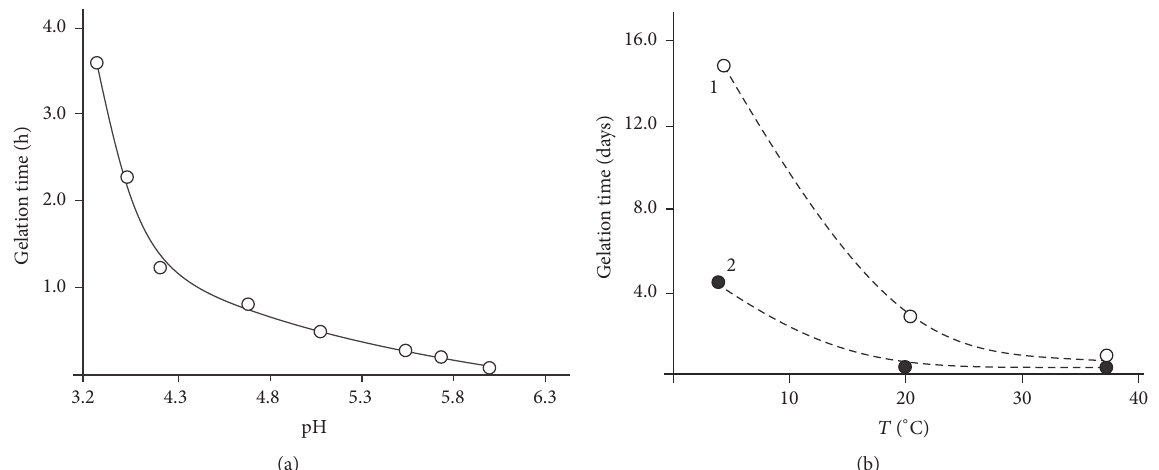
Figure 2: Dependence of the gelation time (a) on pH for the system with 𝐶 SC = 2.67 wt.% and 𝐶 Si = 1.62 wt.% at 37 ∘ b and (b) on the incubation temperature for the system with 𝐶 SC = 3.43 wt.% and 𝐶 Si = 0.69 wt.% without (1) and with 1wt.% NaCl (2) at aX = 3.81 ± 0.04 (1) and 4.26 ± 0.05 (2).